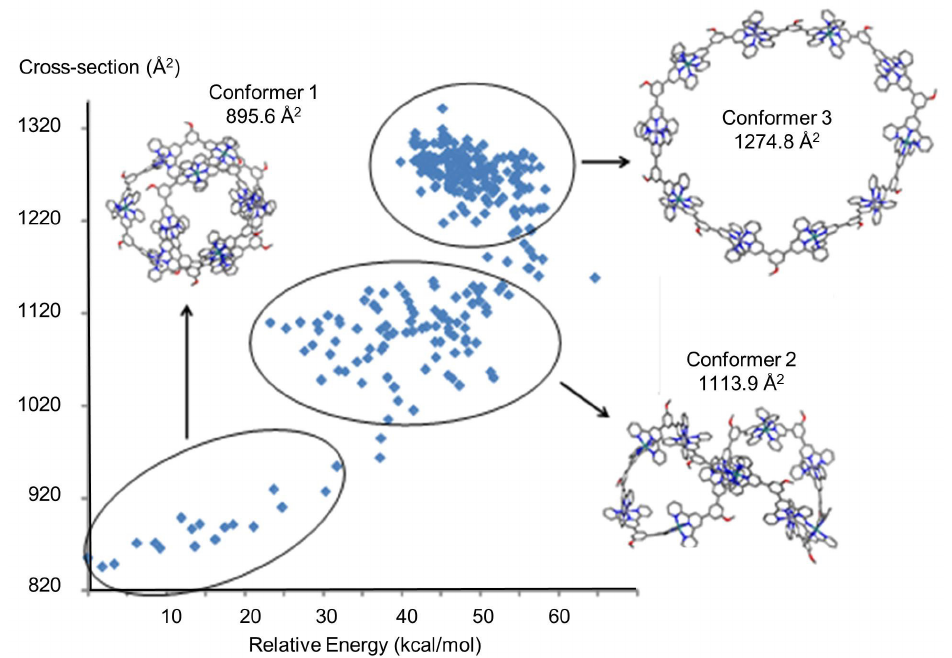
FIGURE 14 – Annealing experiments facilitated a plot of collision cross-sections vs. relative energies for complex 30 revealing three general groupings of conformers [Chan, Y.-T.; Li, X.; Moorefield, C. N.; Wesdemiotis, C.; Newkome, G. R. Chem. Eur. J. , v.17, p.7750-7754, 2011 - Reproduced by permission of Wiley-VCH].